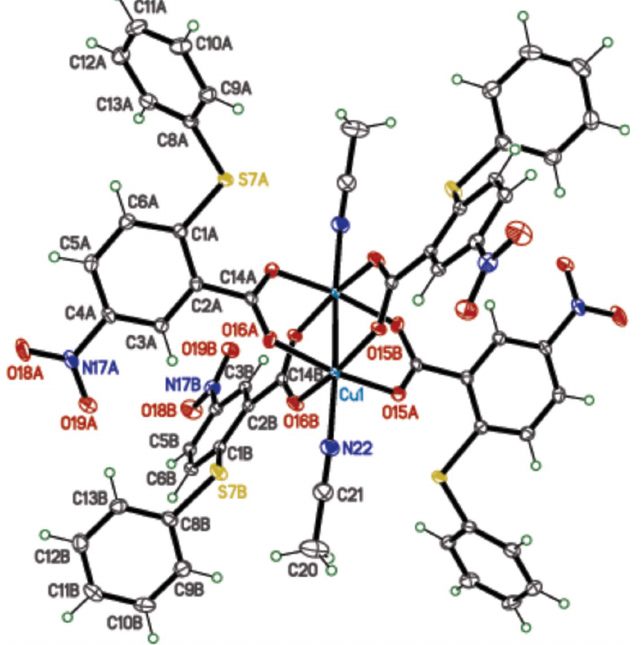
Figure 1 The molecular structure of the binuclear title complex, with displacement ellipsoids drawn at the 50% probability level (arbitrary spheres for the H atoms). Non-labelled atoms are generated by inversion symmetry (symmetry code: (cid:5) x + 1, (cid:5) y + 2, (cid:5) z